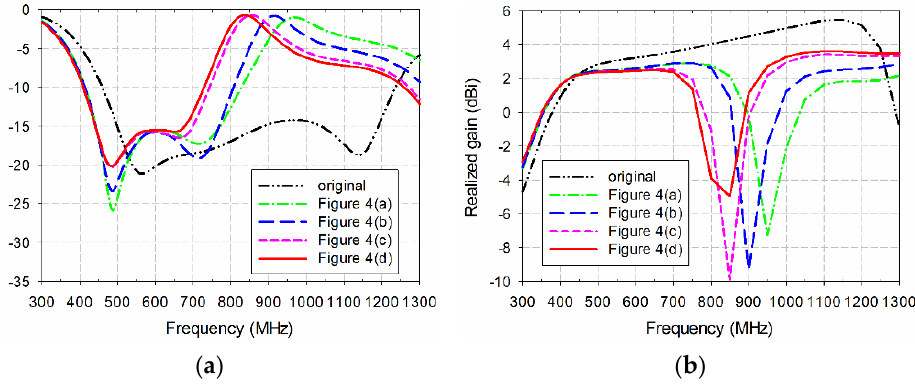
Figure 5. Performance comparison of the four antennas shown in Figure 4 with the original loop antenna: ( a ) the input reflection coefficients, ( b ) the realized gain. Table 3. Frequency band and gain comparison for the results in Figure 5.